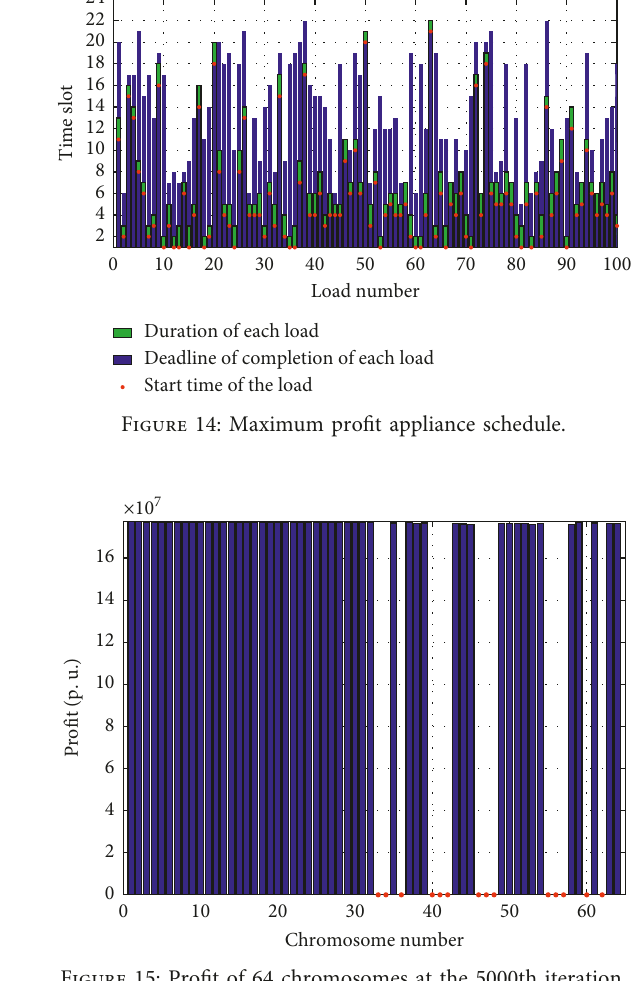
Figure 15: Profit of 64 chromosomes at the 5000th